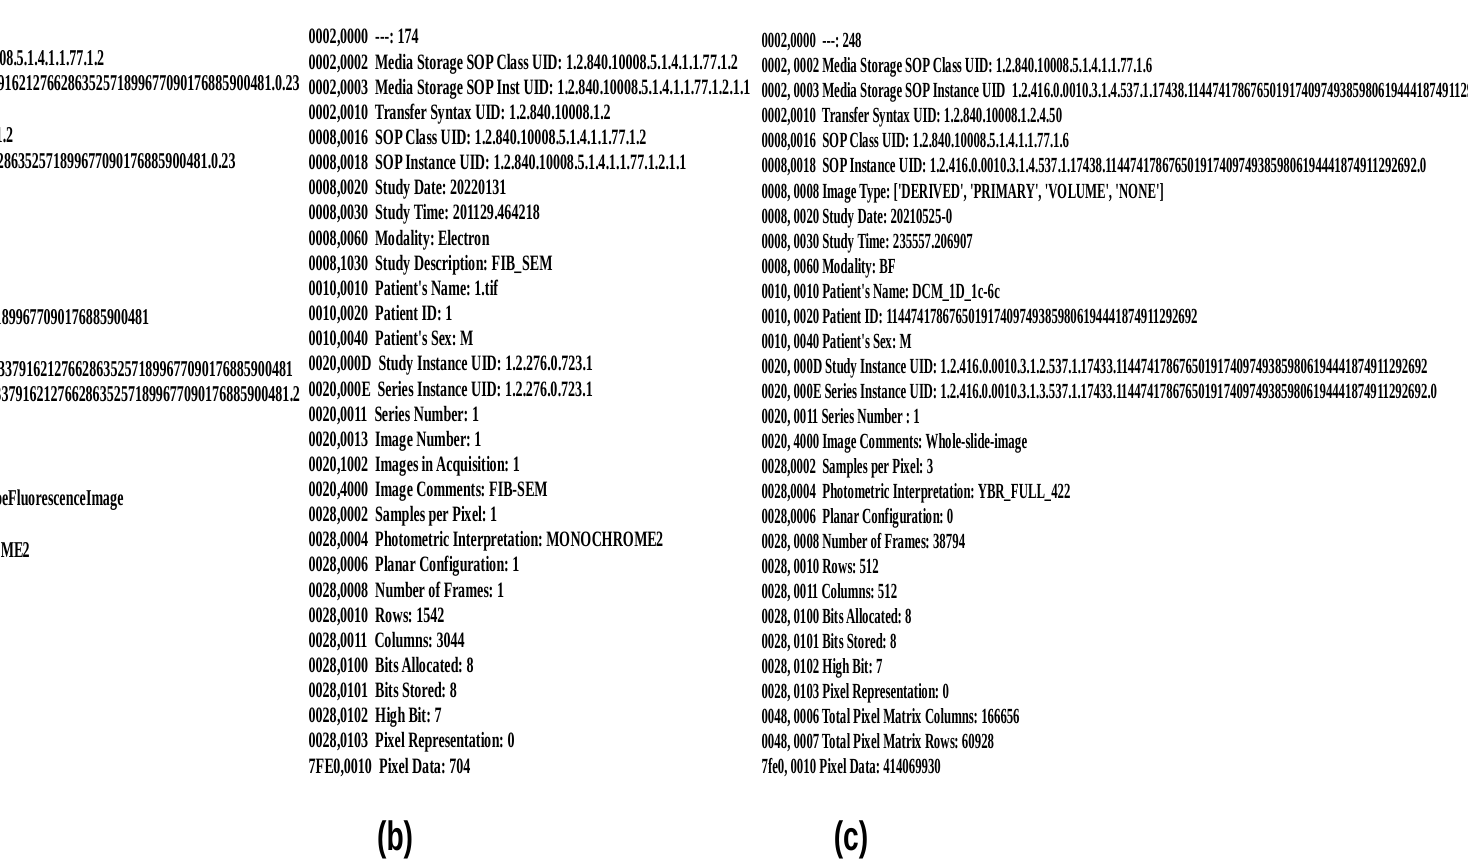
Figure 9. Bioimaging information of each microscope imaging modality is stored inside the metadata of each image: ( a ) Biological information of channel-1 of CLSM image (Nikon scanner), ( b ) FIB-SEM .tif sample biological information, ( c ) Metadata information about WSI sample (DCM_1D_1c-6c), base resolution